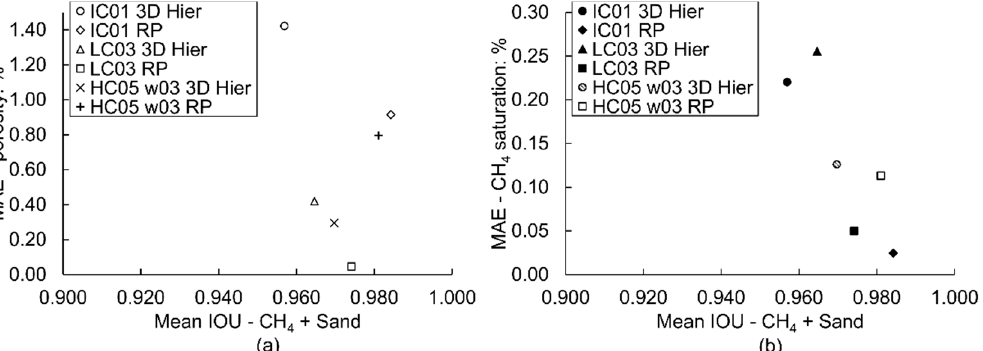
Figure 10. Porosity and CH 4 gas saturation profiles for the central 40 XY slices of data sets IC01 ( a , b ), LC03 ( c , d ) and HC05 ( e , f ) derived using image segmentations obtained from 3D hierarchical and RootPainter U-Net models trained on sub-volumes of IC01 ( a , b ) and LC03 ( c – f ). Parameters derived from manual thresholding and watershed segmentation methods also shown.